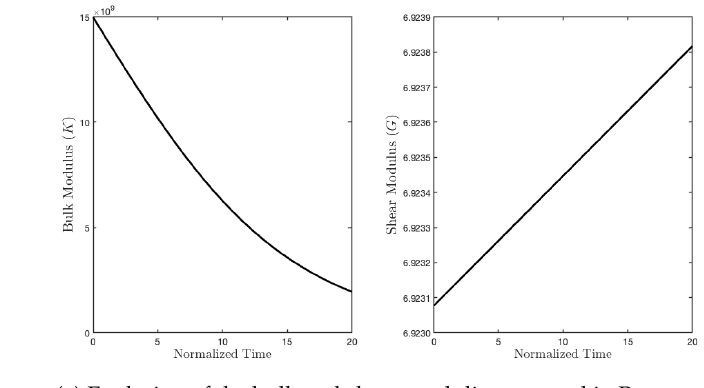
( a ) Evolution of the bulk and shear moduli, expressed in Pa.